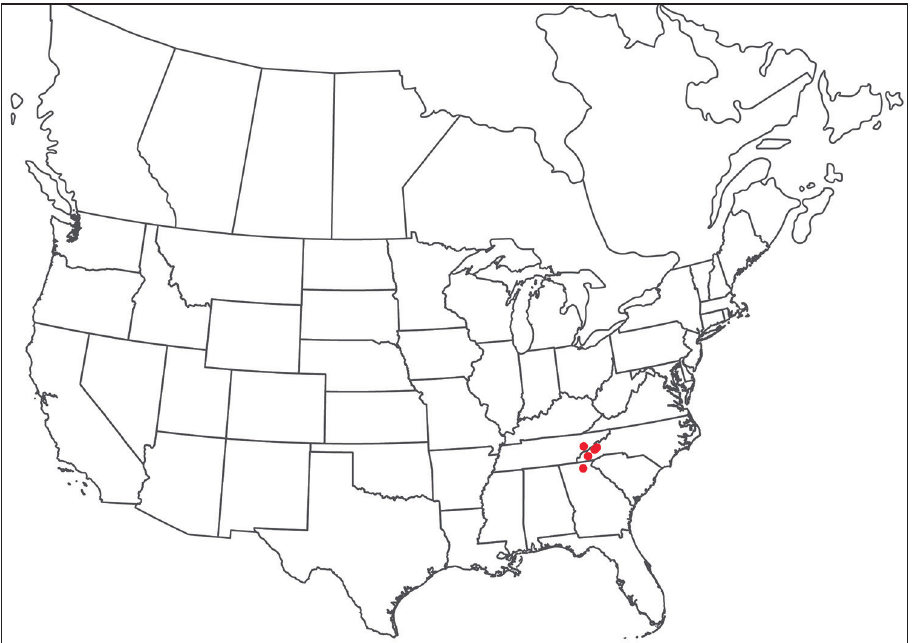
Figure 21. Torrenticola arktonyx sp. n.